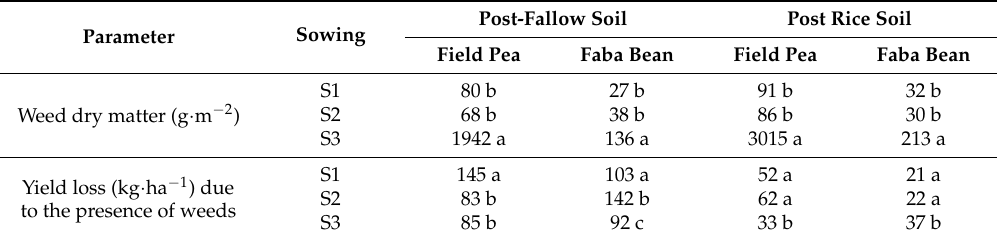
Figure 8. 100-seed weight ( a ) and the percentage of disease-infested seeds for faba bean ( b ) at three Figure 8. 100 ‐ seed weight ( a ) and the percentage of disease ‐ infested seeds for faba bean ( b ) at three sowing dates in post-rice and post-fallow plots. Appearance of faba bean seed grown in post-fallow sowing dates in post ‐ rice and post ‐ fallow plots. Appearance of faba bean seed grown in post ‐ fallow and post-rice plots on different sowing dates ( c ). and post ‐ rice plots on different sowing dates ( c ). Table 2. Comparative analysis of the weeds’ biomass and yield loss due to weeds present in post-rice and post-fallow treatments at three different sowing dates (S1, S2 and